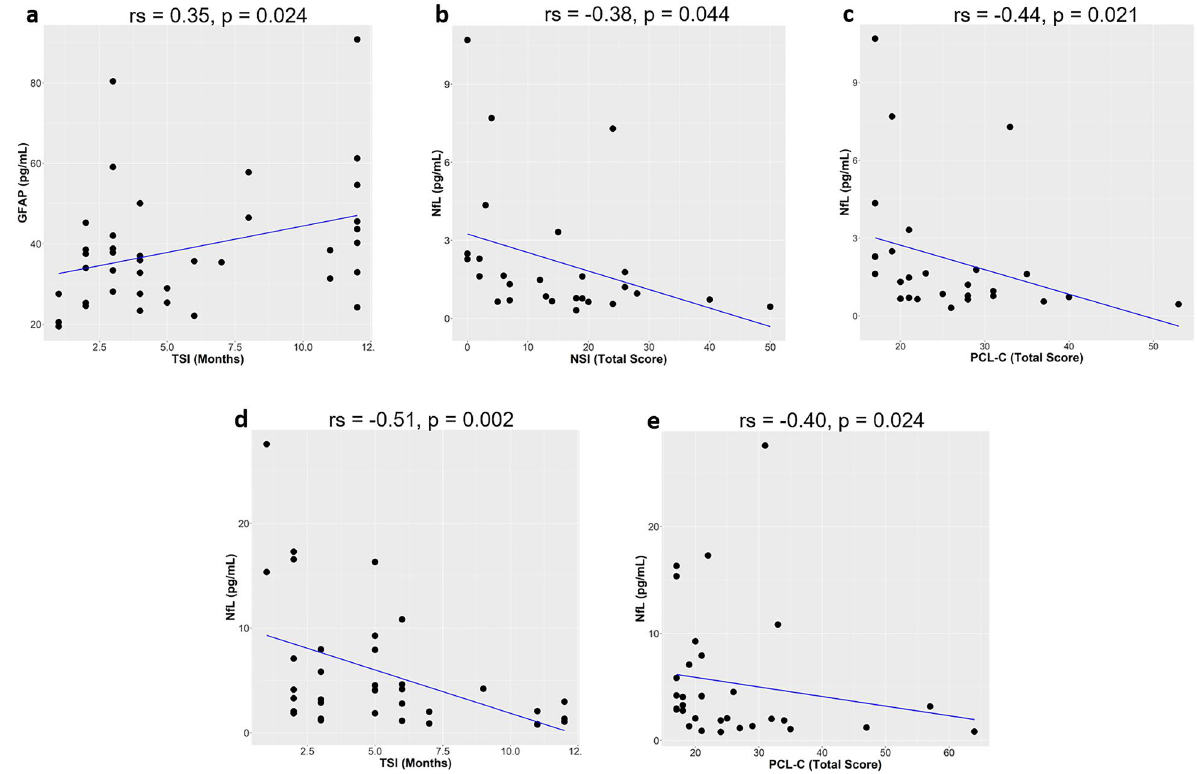
Figure 3. Correlations between biomarker levels and time since injury (TSI, months) or behavioral scores within one year of injury in the mTBI group ( a – c ) and smcTBI group ( d , e ). For each correlation, rho (r s ) and p values are provided (Spearman rank correlations). Regression line is shown in blue. One influential data point was removed from the mTBI group as it greatly affected the slope of the regression line involving either NfL or GFAP. Concentrations of NfL and GFAP for the data point were higher than the median plus 3 median absolute deviations. GFAP, glial fibrillary acidic protein; NfL, neurofilament light chain; TSI, time since injury (months); PCL-C, PTSD Checklist-civilian Version; NSI, Neurobehavioral Symptom